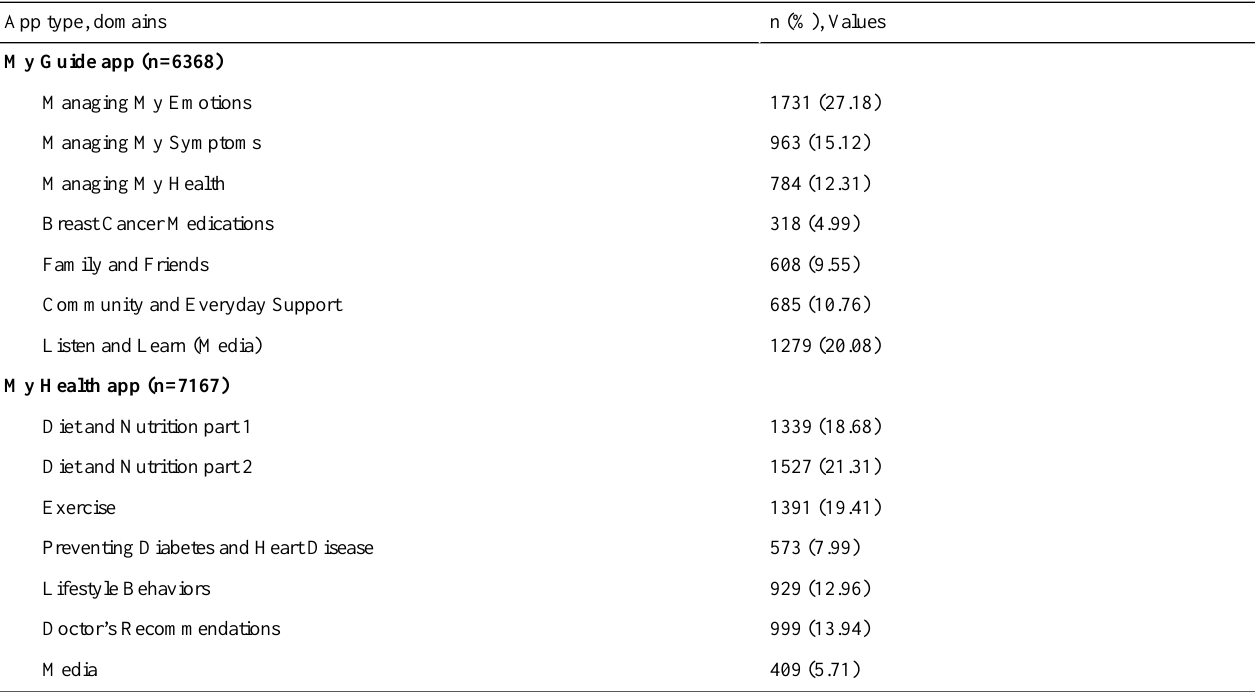
Table 3. Total number of clicks for each domain within each